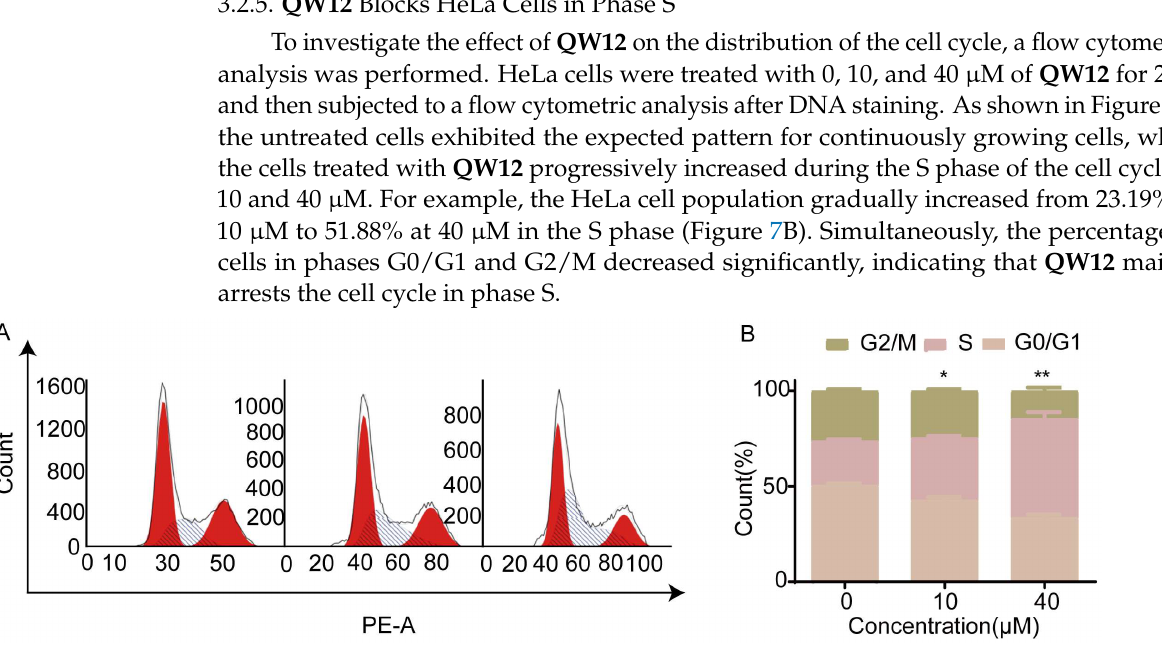
Figure 7. QW12 causes S-phase arrest in HeLa cells. ( A ) QW12 causes S-phase arrest in HeLa cells in a concentration-dependent manner. ( B ) Quantitative statistics of the results in ( A ) using the Graphpad software. Values are presented in means ± SD of three independent experiments. n/s is not significant, * p < 0.1, ** p < 0.01 .